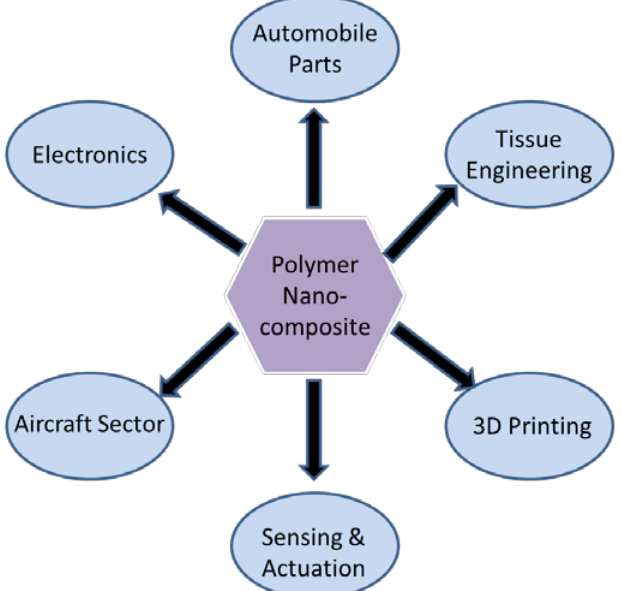
Figure 8. Application of polymer nanocomposites.